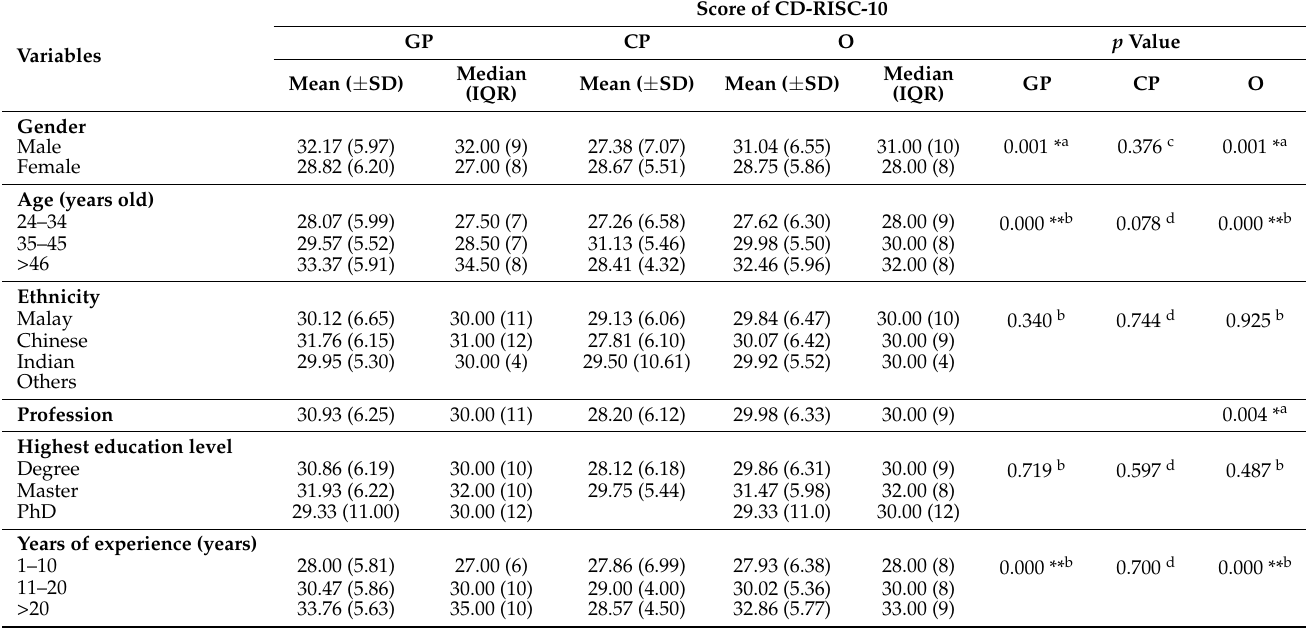
Table 4. Comparison of CD-RISC-10 across independent